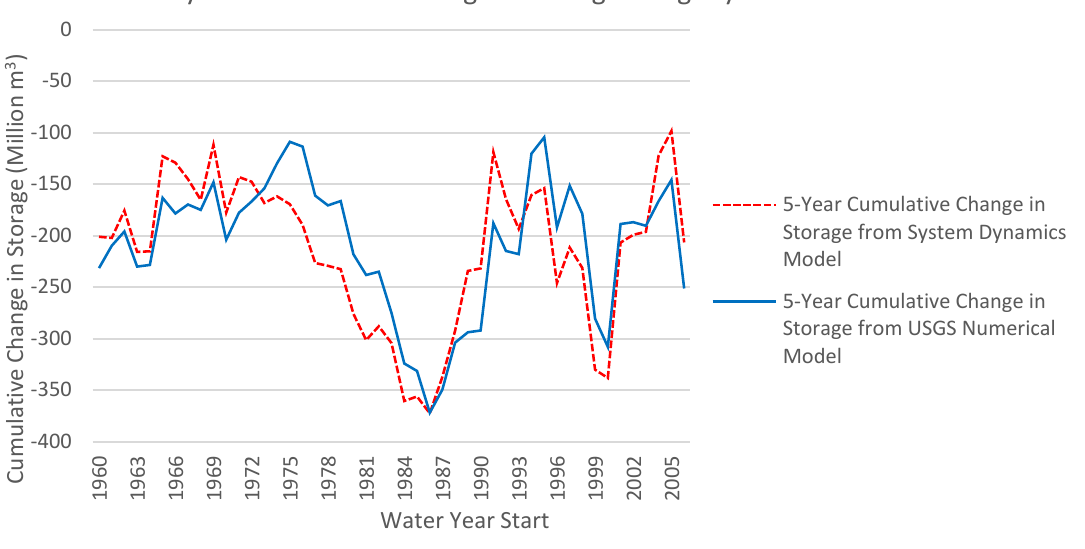
Figure 6. Cuyama Basin 5-year groundwater system simulation.